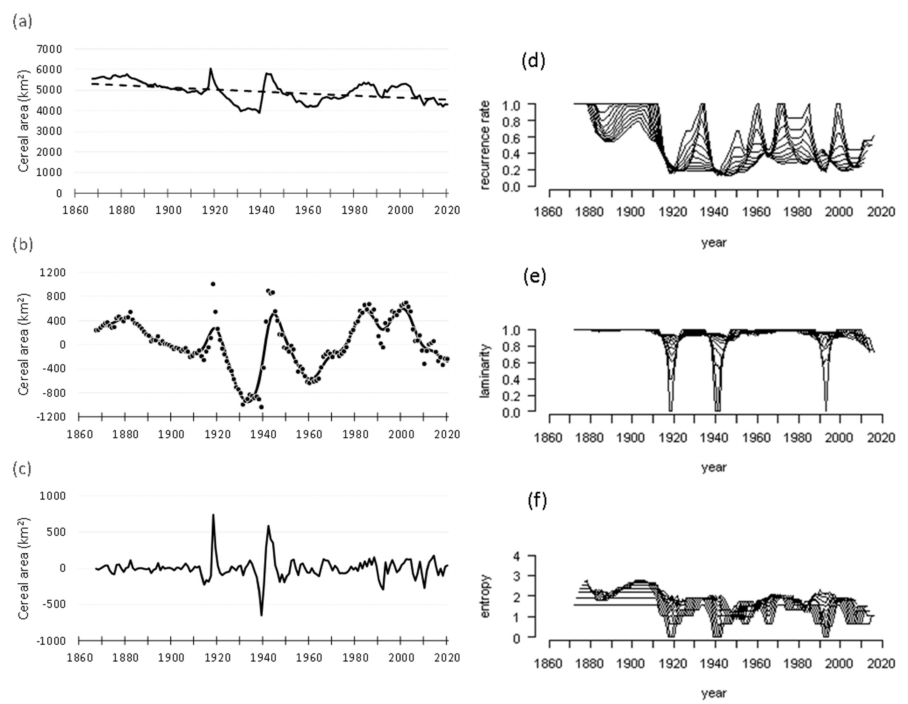
Figure 5. Time series analysis results and RQA results for cereal area in Scotland (1867–2020): ( a ) data and long-term trend, ( b ) deviation from long-term trend and smoothing spline, ( c ) residuals from long- and medium-term trends, ( d ) recurrence rate, ( e ) laminarity, and ( f ) entropy from RQA using sliding windows of 10–30 years duration in 2-year increments.